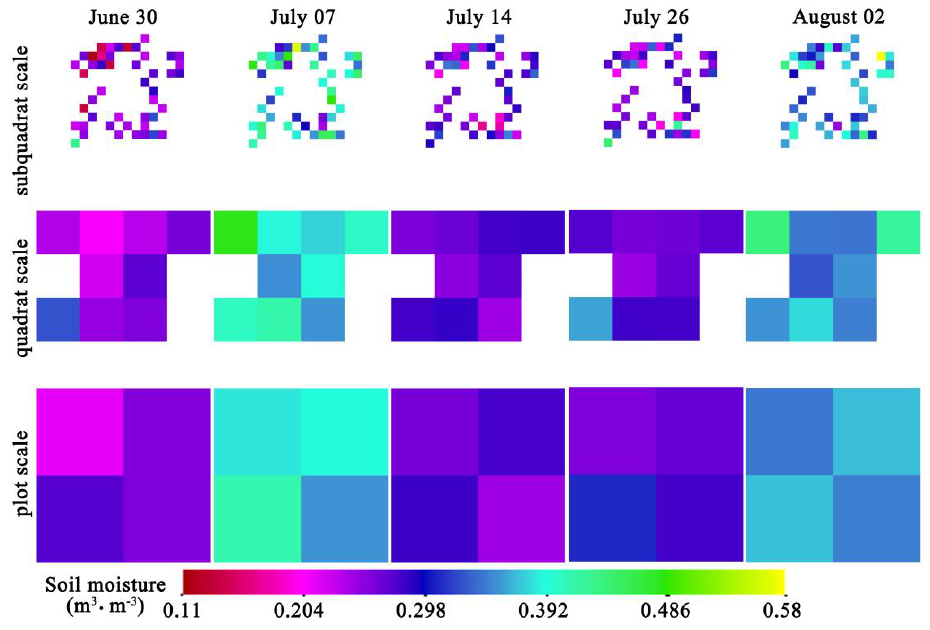
Figure 8. Upscaled soil moisture estimations at the scale series by simple averaging on five acquisition days.